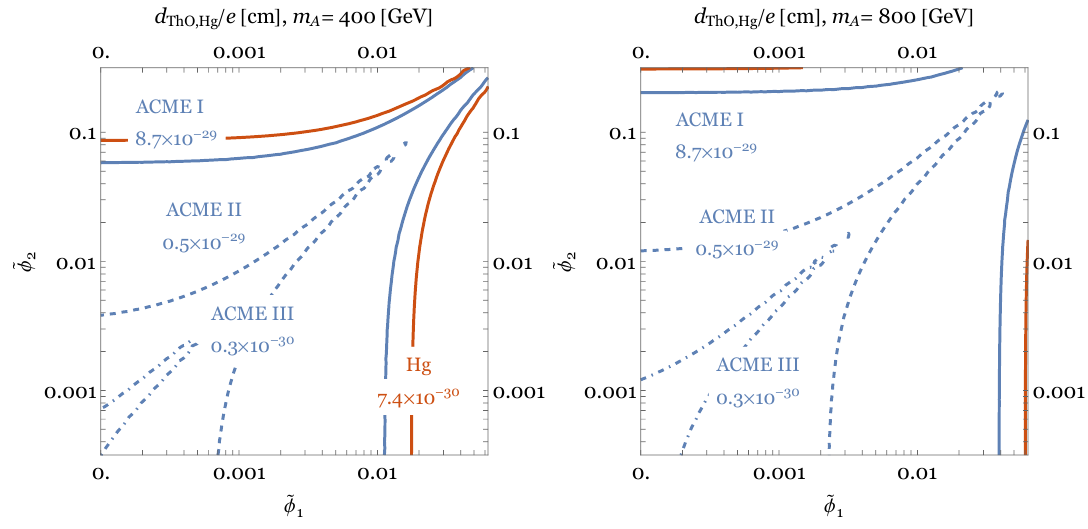
Figure 16 . EDM constraints on the CP-violating phases ~ (cid:30) 1 ; 2 in the BMSSM scenario. We take m A = 400 ; 800 GeV for the left and right panels respectively. Regions of parameter space to outside the solid blue and red contours are excluded by measurements of ThO and Hg (the case (i)), respectively. The mercury EDM constraint for the case (ii) is weak and not shown in the (cid:12)gures. The blue dashed and dot-dashed contours (\ACME II" and \ACME III") are future projections. We have (cid:12)xed j (cid:15) 1 ; 2 j = 0 : 1, tan (cid:12) = 5 and (cid:22) = 350 GeV in these